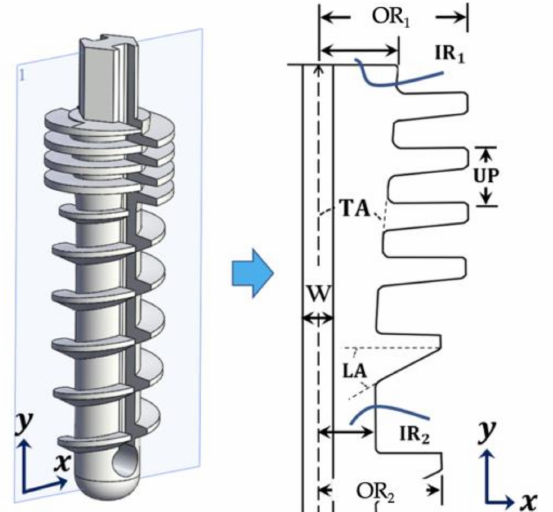
Figure 2. Dimensional characteristics of the proposed suture anchor design. Four design parameters, tapered angle (TA), upper thread pitch (UP), groove width (W), and lower thread angle (LA) are indicated. Outer (OR) and internal radii (IR) are also